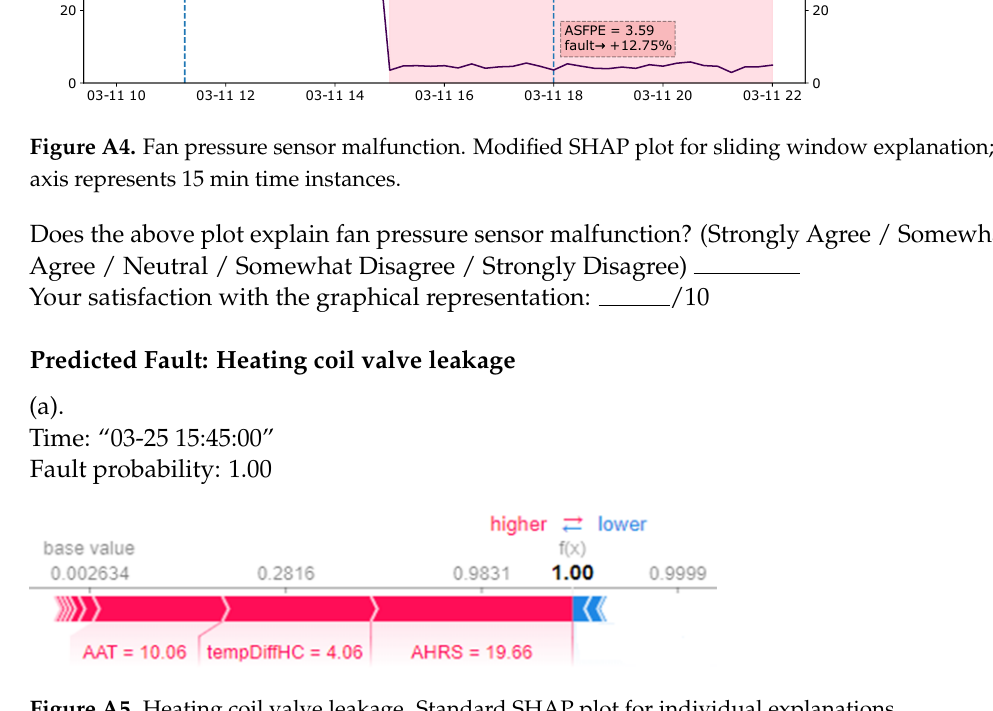
Figure A5. Heating coil valve leakage. Standard SHAP plot for individual explanations. Does the above plot explain fan pressure sensor malfunction? (Strongly Agree / Somewhat Agree / Neutral / Somewhat Disagree / Strongly